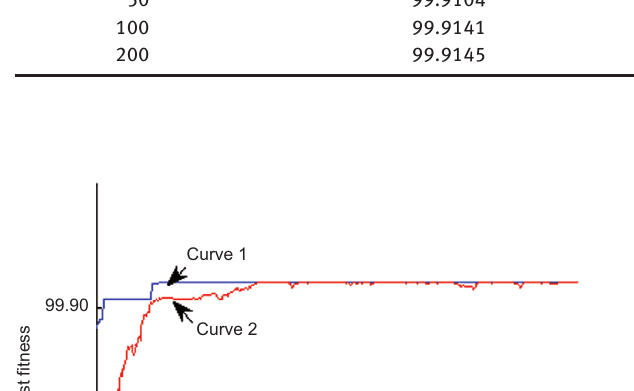
curveCurve 1: Individual optimal fitness value Curve 2: Individual average fitness value Figure 6. The Convergence Curve when the Population Size is Set to 50.